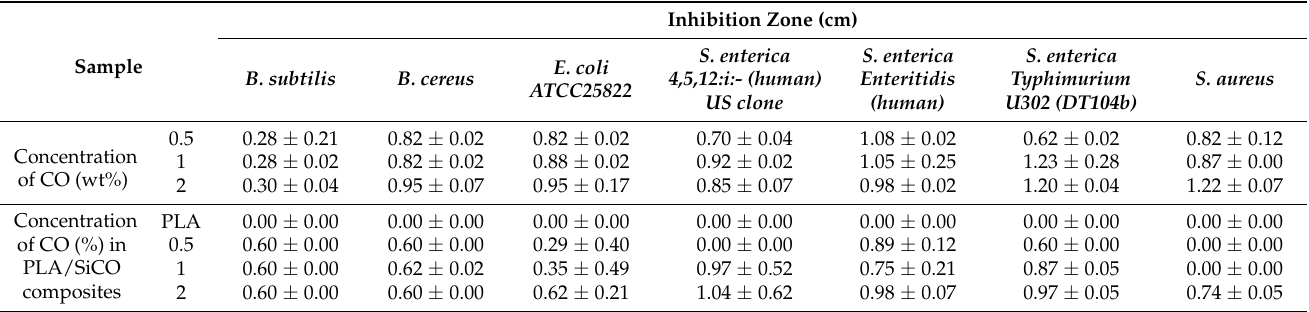
Table 6. Inhibition Zone [63].